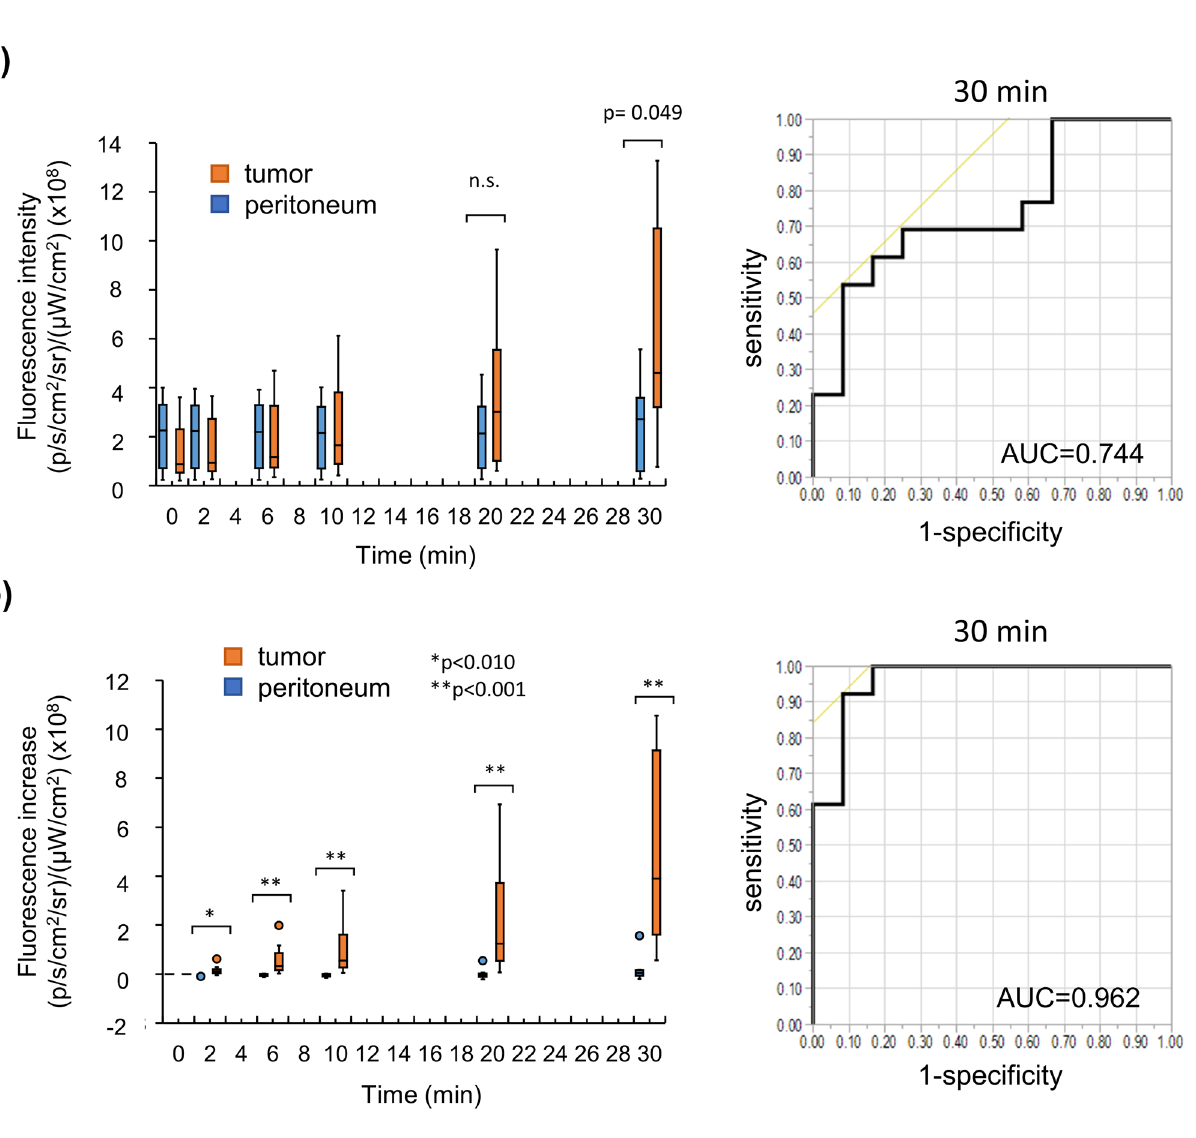
Figure 4. ( a ) Time course of fluorescence intensity of the tumor and peritoneum in all cases and ROC at 30 minutes after spraying SPiDER-βGal. ( b ) Time course of the fluorescence increase in the tumor and peritoneum in all cases and ROC at 30 minutes after spraying SPiDER-βGal. β-Gal, β-galactosidase; ROC, receiver operating characteristic curve; n.s., not